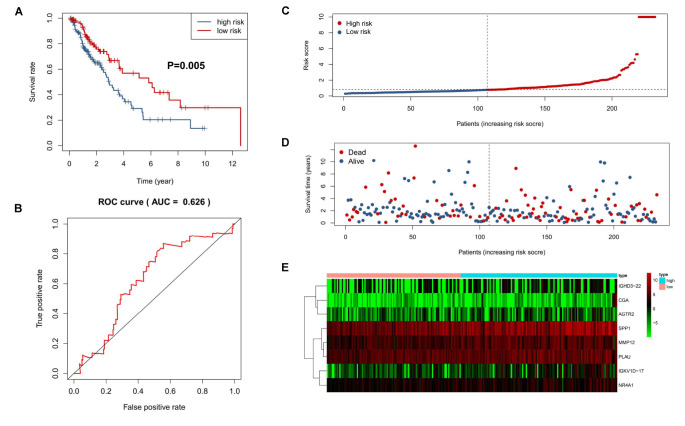
Validation of an 8-IRG signature in the validating cohort. (A) Kaplan-Meier curve analysis of overall survival of SQLC patients in high- and low-risk groups. (B) ROC curves analysis of 1 year. Risk score distribution (C), survival status (D), and heatmap of expression profiles (E) for patients in high- and low-risk groups by the 8-IRG signature.